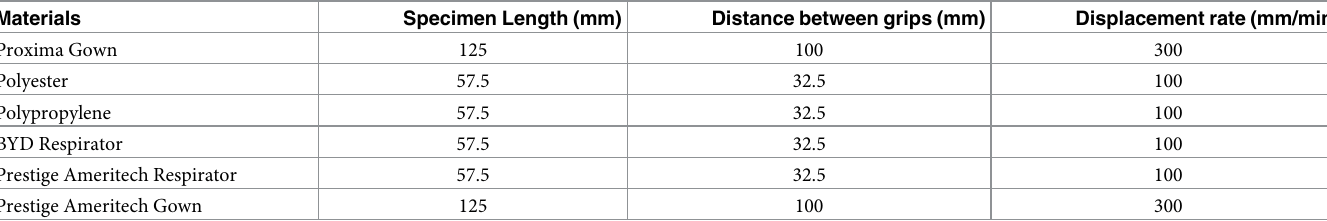
Table 5. Experimental parameters used for the Proxima gowns and filter materials in tensile testing.